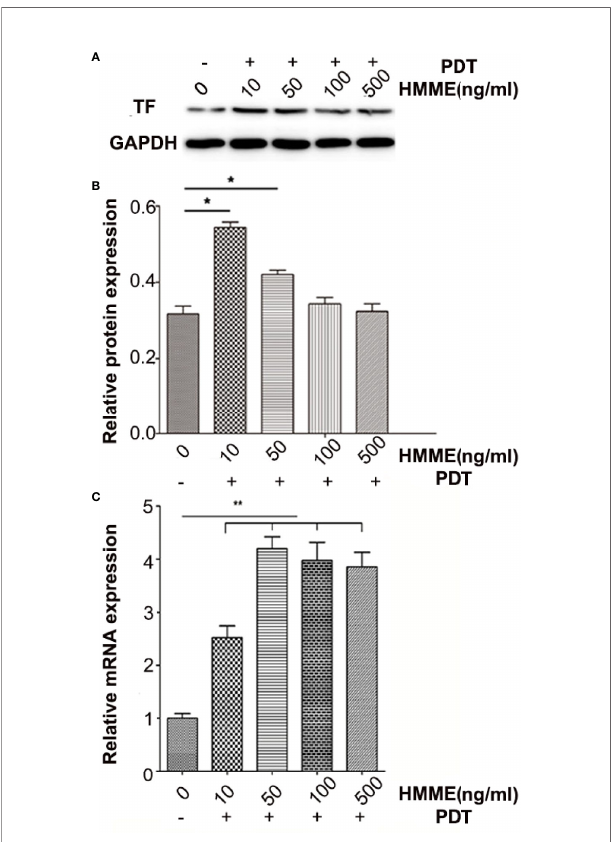
FIGURE 3 | TF expression of HUVECs post-PDT. (A) TF protein expression was analyzed by western blotting and normalized by GAPDH and blank HUVECs; (B) analysis of grey-level in picture A; (C) relative folding of TF mRNA after normalizing to GAPDH mRNA and blank HUVECs. Data are expressed as the mean ± SD (n = 3); *p < 0.05, **p < 0.01, compared with control